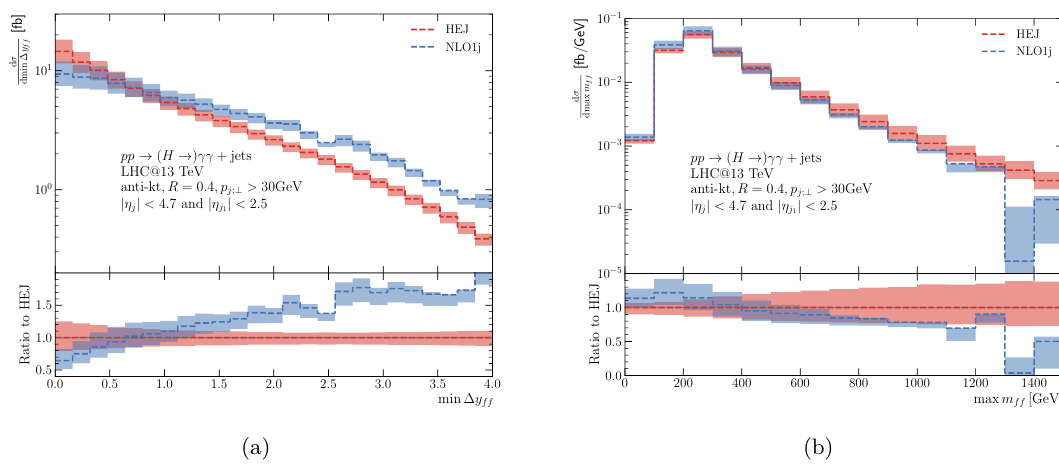
Figure 7. High-energy sensitive inclusive 1-jet distributions: (a) the minimum rapidity separation between any two outgoing particles (Higgs boson or jets) and (b) the maximum invariant mass between any two outgoing particles (Higgs or jets). HEJ results are rescaled by the inclusive cross section ratio σ NLO1J /σ . HEJ 1J